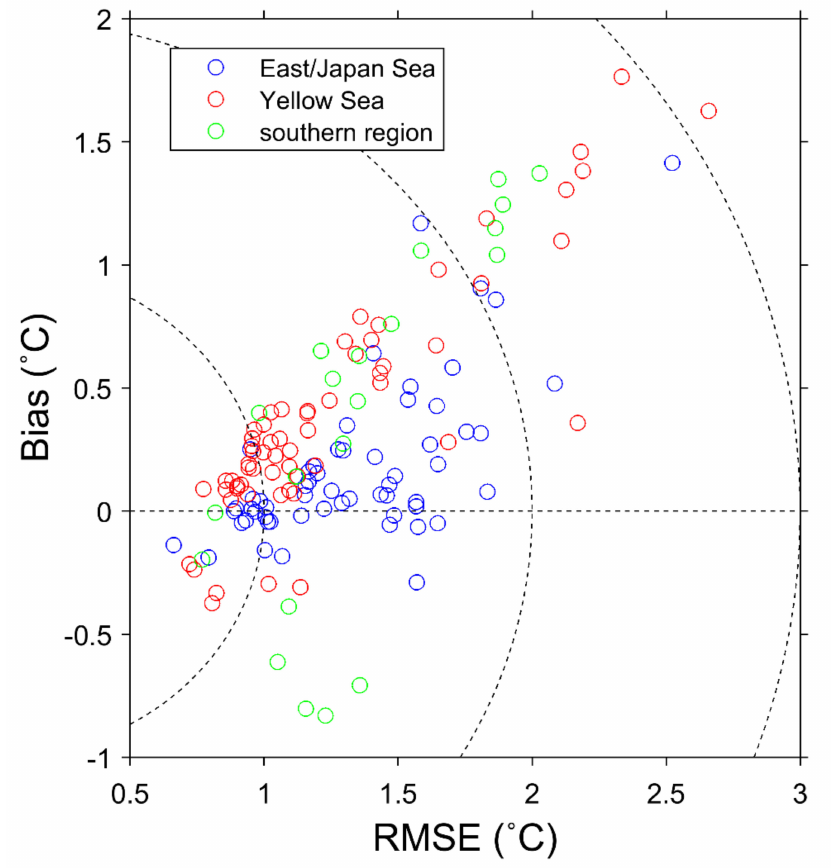
Figure 6. Scatter plot of RMSE and bias error of SSTs for each KODC observation station (the East / Japan Sea, the Yellow Sea, and the southern region of the Korean Peninsula), where the dotted contours represent the constant values of the distances from the origin with zero RMSE and zero